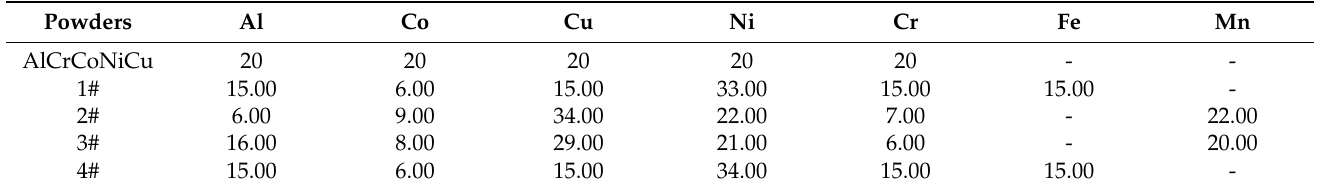
Table 1. Chemical compositions of 5 kinds of high entropy alloy ingots produced by vacuum arc melting. (at. %).